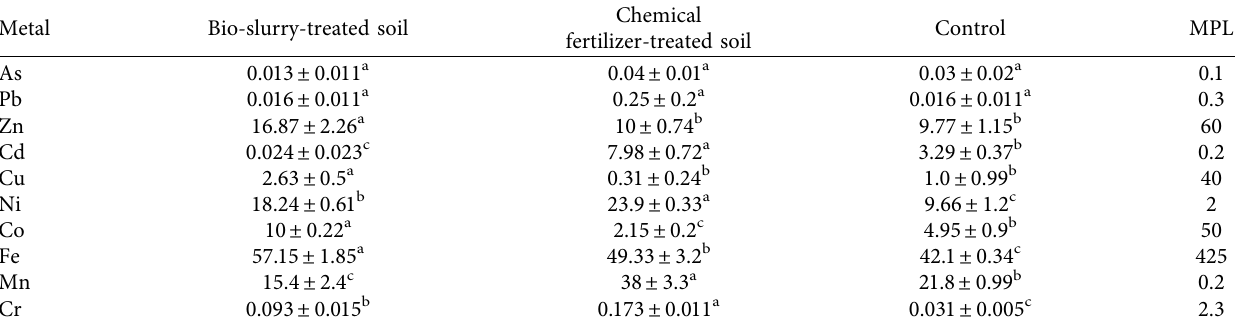
Table 7: Concentrations of heavy metals (mg kg − 1 ) in tomato fruits grown in bio-slurry and chemical fertilizer-treated soil and control soil. Metal Bio-slurry-treated soil